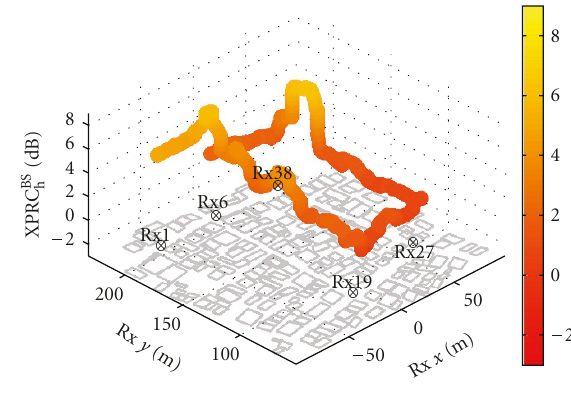
Figure 29: XPRC MS